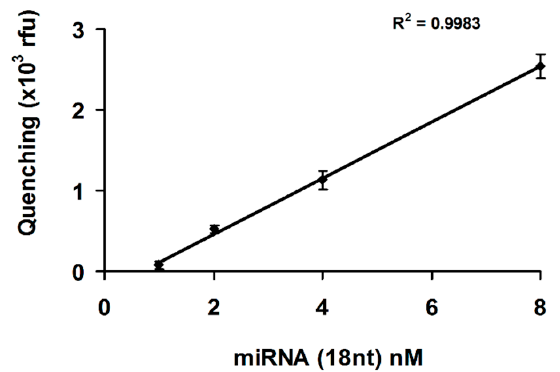
Figure 4. The FAM-DNA fluorescent probe was used in the presence of 25% cell culture medium supplemented with platelet lysate. GO was added after FAM-DNA/microRNA 18nt hybridization. The experiments were done in triplicate samples. Error bars represent the standard deviations of triplicate values.